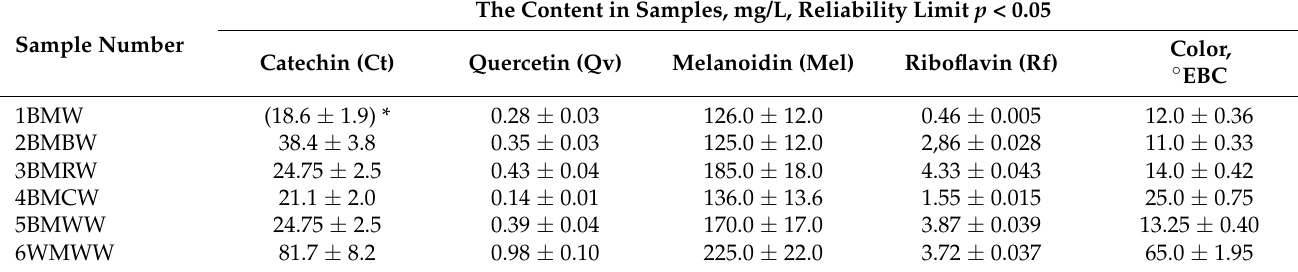
Table 5. The characteristics of wort samples, which form